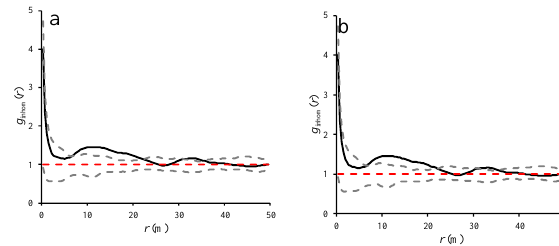
Figure 9. Inhomogeneous g -function at scales of 0-50 m (a) and 150-200 m (b) for heterogeneous pattern of wild pistachio trees. Heterogeneity of the pattern of wild pistachio trees biased homogeneous g -function, as was the case for other homogeneous functions ( K - and L -function). Homogeneous g - function indicated a strong aggregation at scales of 6-22 m and 28 -38 m , and weak aggregation at all other scales (Fig. 10a). Despite a weak regularity of the trees at scales of 150-162 m (Fig. 9b), homogeneous g -function indicated a weak aggregated distribution at scales of 179-184 m and randomness at all other scales (Fig.